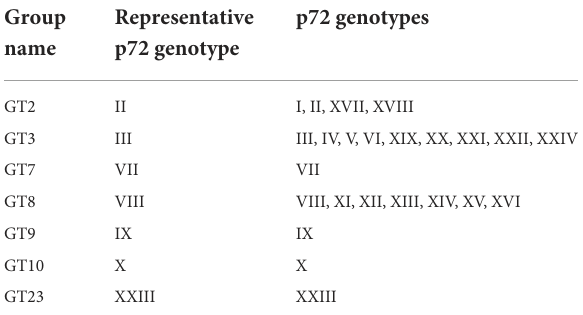
TABLE 1 Classification of 24 genotypes of the genes for ASFV p72